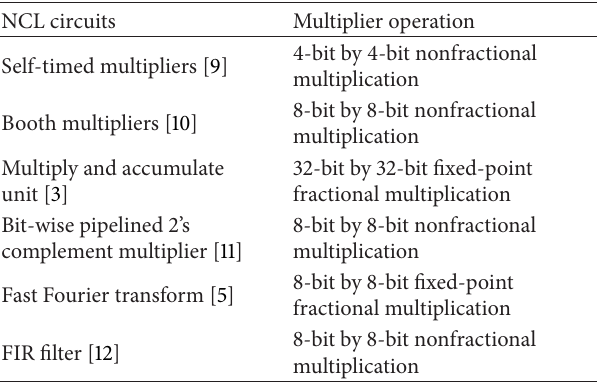
Figure 3: IEEE 754 single precision floating point format.